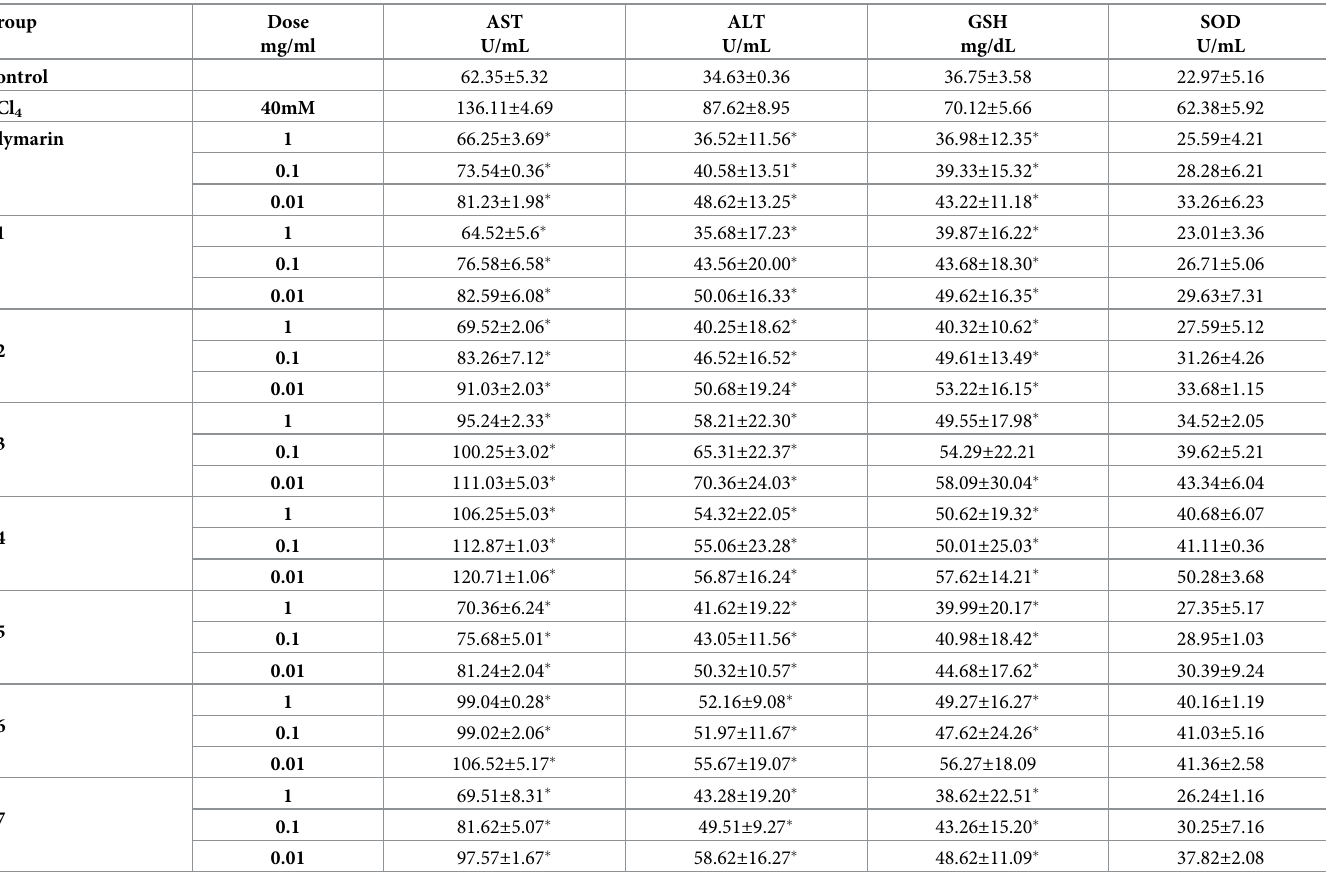
Values are mean ± S.D. of three independent experiments carried out in triplicates.